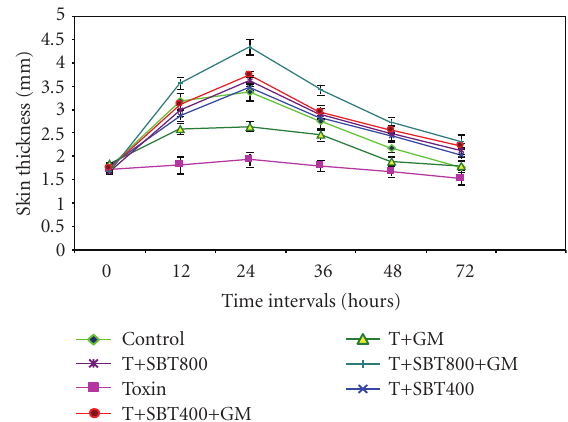
(SBT) and glucomannan (GM, mycotoxin binder) on skin thickness (mm) in delayed-type hypersensitivity reaction in birds fed with T-2